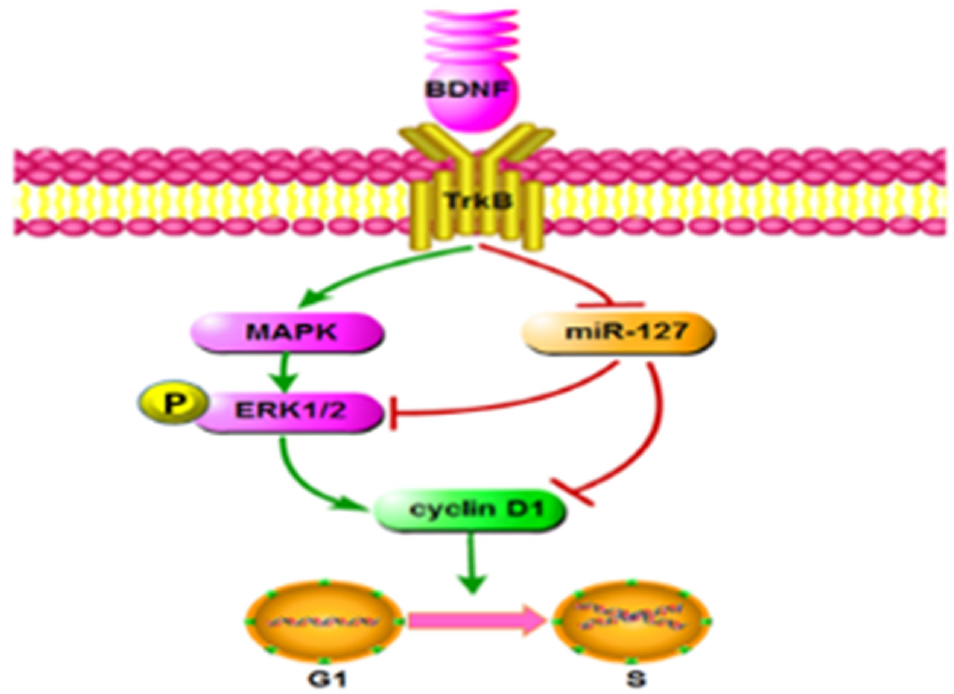
Figure 5. Proposed model of the mechanisms for BDNF, promoting the proliferation of porcine follicular GCs. BDNF directly activates the MAPK-ERK signaling pathway by binding to TrkB and upregulates the expression of CCND1. Subsequently, it promotes the transition of cells from the G1 to S phase. On the other hand, after binding to TrkB, BDNF indirectly promotes the expression of CCND1 by downregulating miR ‐ 127.